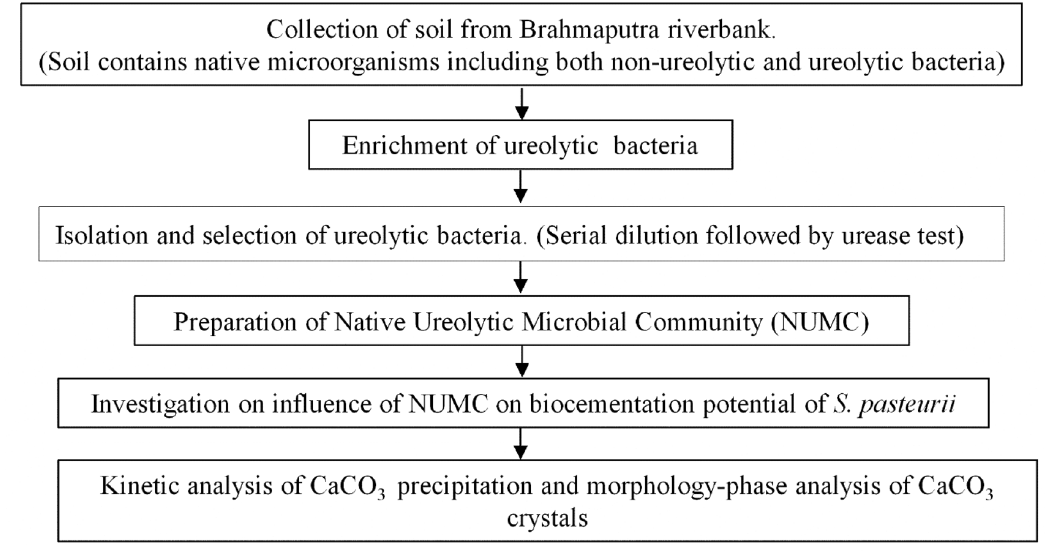
Figure 5. Schematic diagram of this